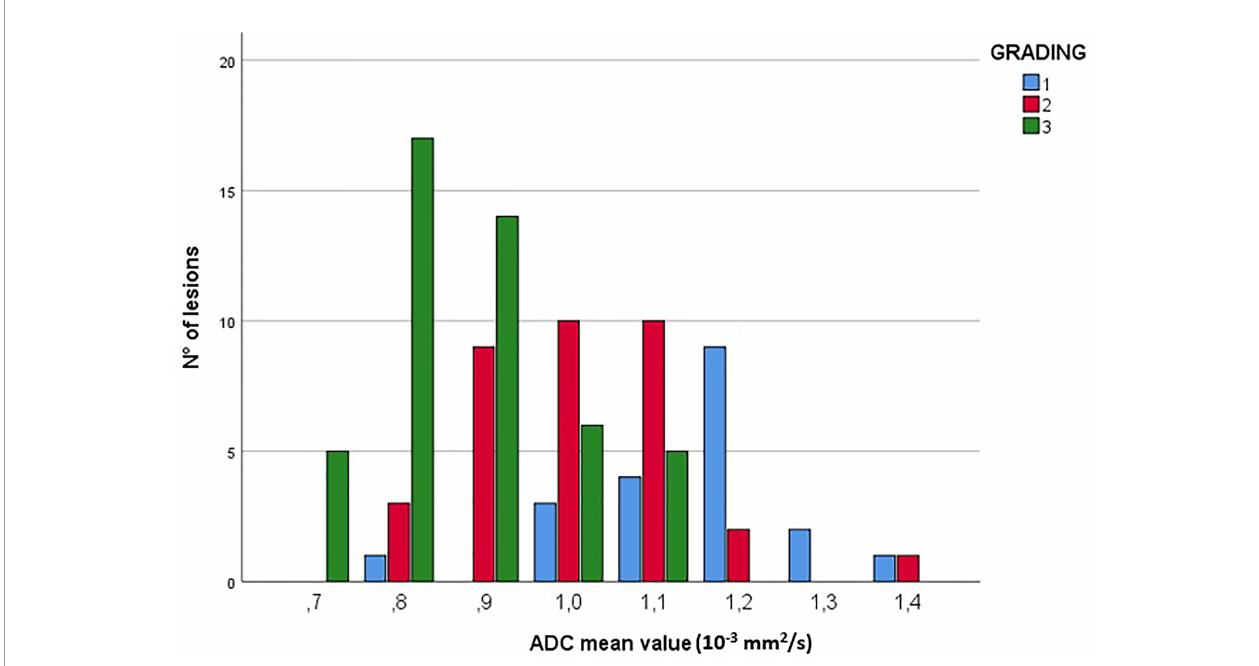
FIGURE 6 | Correlation between ADC values (10 -3 mm 2 /s) and lesion grading. The fi gure shows the prevalence of low ADC values ( ≤ 1.1x10 -3 mm 2 /s) in G2 and G3 lesions.